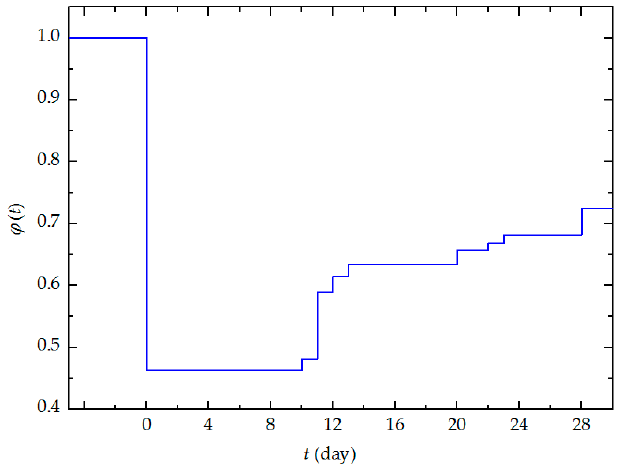
Figure 4. Performance recovery trajectory of the supply chain network.